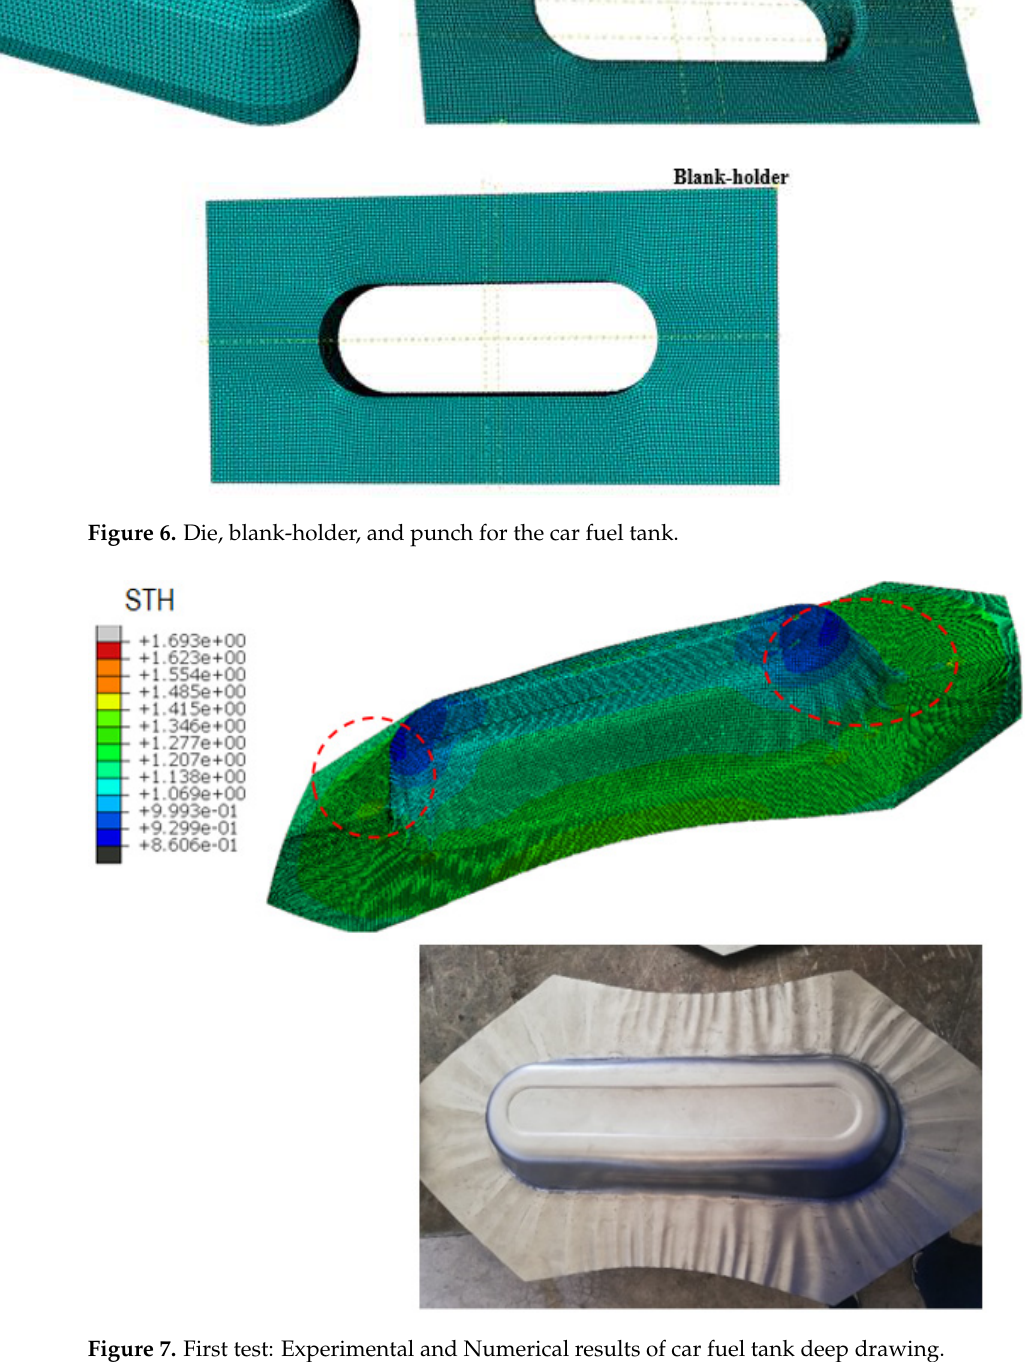
of radial tensile stress and tangential compressive stress (hoop stress). The main defects of deep ‐ drawn parts are wrinkling and/or necking. Wrinkling usually occurs at the flange Figure 7. First test: Experimental and Numerical results of car fuel tank deep drawing. region by excessive compressive stresses leading to local buckling of the sheet. On the kling and necking, define the limits of the deep ‐ drawing process. We illustrate in Figure 8 the distribution of damage parameter D (second test).